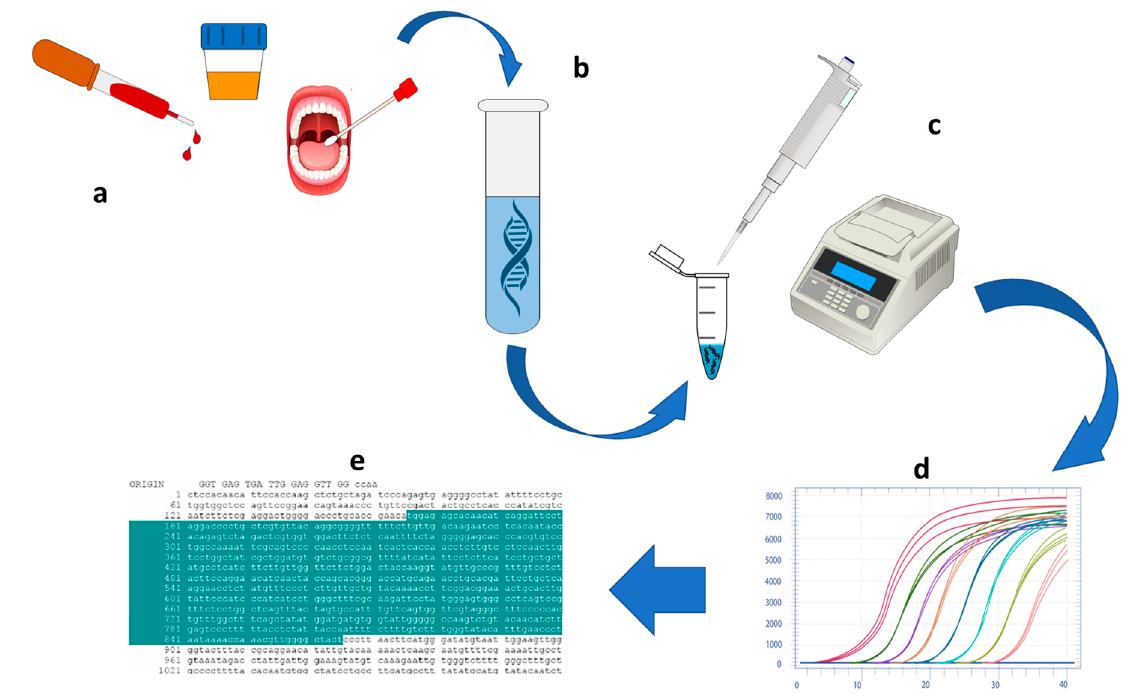
Figure 1. NAT analytical steps based on PCR: ( a ) sample collection; ( b ) NA extraction; ( c ) PCR amplification; ( d ) real-time PCR quantification; ( e ) sequence detection results.